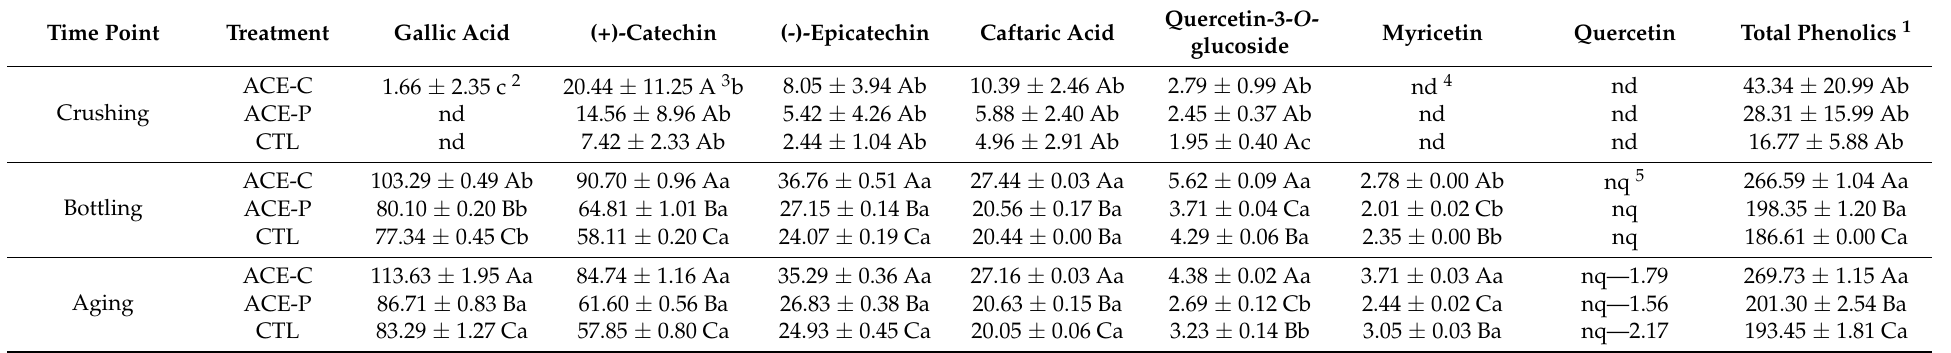
1 Sum of all monomeric non-anthocyanin phenolic compounds as listed in the table. 2 Different lowercase letters within the same column indicate significant differences in the content of the measured variables among the different time points ( p < 0.05) within same sample. 3 Different uppercase letters within the same column indicate significant differences in the content of the measured variables among the different treatments ( p < 0.05) within same time point. 4 nd, not detected. Values below detection limit. 5 nq, not quantified. Values below quantification